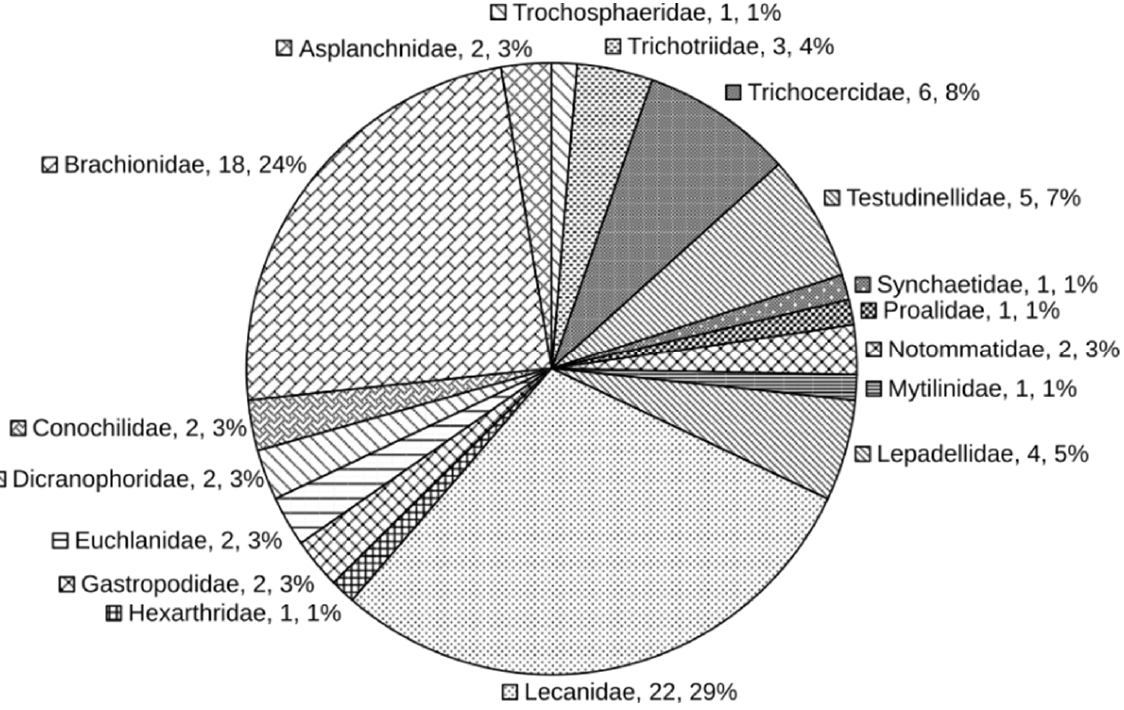
Figure 2. Community structure of planktonic rotifers in Da Nang (the values on graph indicate the family name, number of taxa, and percentage).